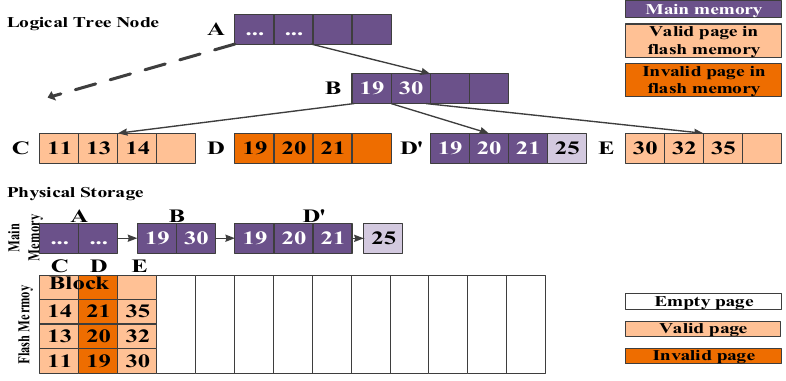
Figure 10. Structure of the physical storage in CB-tree.